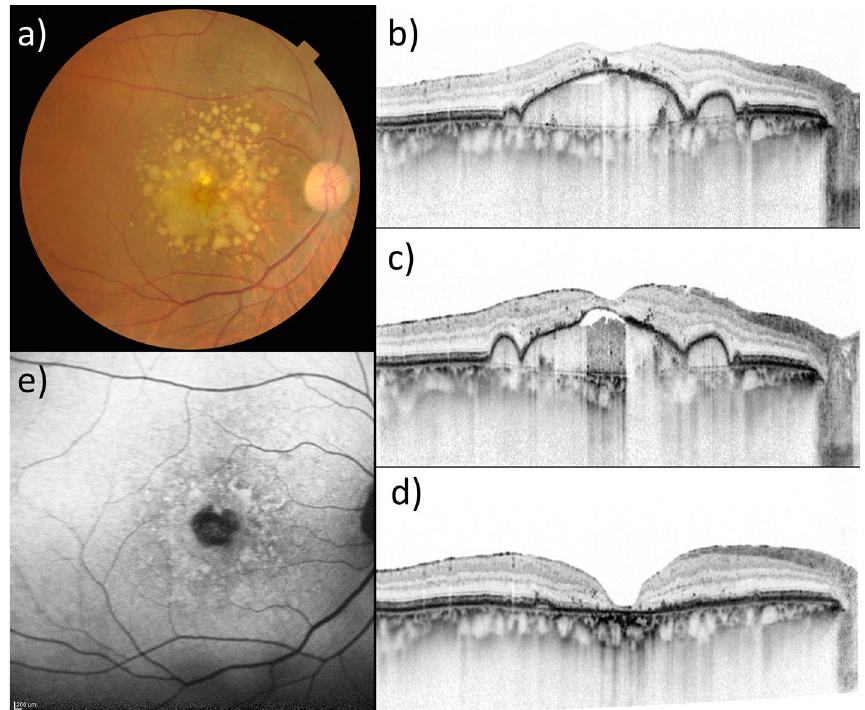
Figure 2. Drusenoid PED in the right eye of a 71-year-male. ( a ) Baseline color fundus photograph of the right eye. ( b ) Baseline horizontal OCT scan showed that the drusenoid PED width and height were 3943 µm and 307 µm, respectively. ( c ) RPE defect and choroidal hypertransmission was seen 3 months before the GA development. ( d ) PED collapse was seen 18 months after the initial presentation. ( e ). ( f ) Hypoautofluorescence was seen at the region corresponding to GA on fundus autofluorescence.